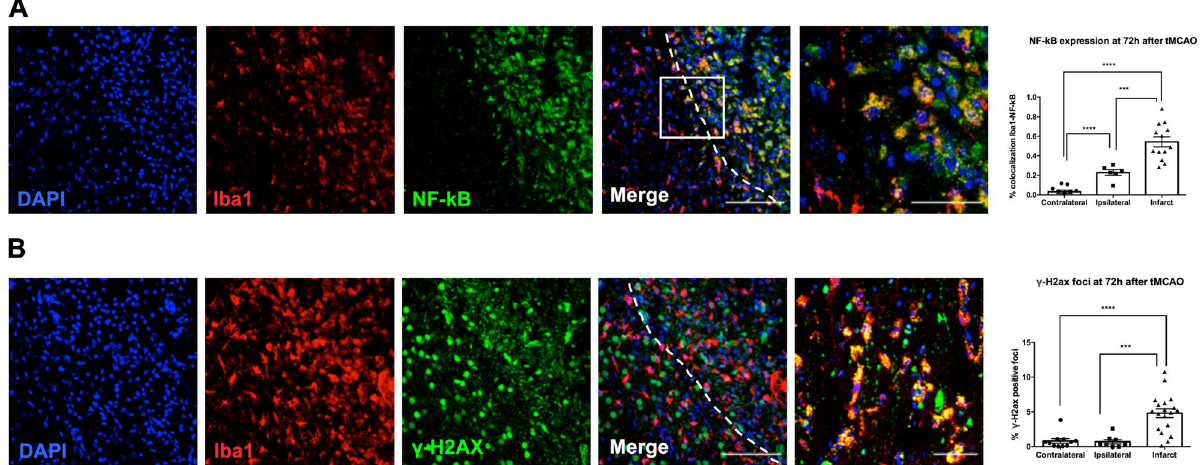
Figure 3. Microglial cells of the ischemic area showed a higher expression of NF-kB and γ-H2AX. ( A ) Immunofluorescence NF-kB expression showed an infarct area location, delimited by white dotted line. Plot represented the NF-kB expression by areas (contralateral vs infarct area: p < 0.0001; ipsilateral vs infarct: p = 0.0009; contralateral vs ipsilateral: p < 0.0001). Scale bar = 100 µm; insert scale bar = 40 µm. ( B ) Nuclear expression of γ-H2AX in microglial cells. Plot represented the γ-H2AX positive foci in contralateral, ipsilateral and infarct areas (contralateral vs infarct: p < 0.0001; ipsilateral vs infarct: p = 0.0004). Scale bar = 100 µm; insert scale bar = 50 µm.